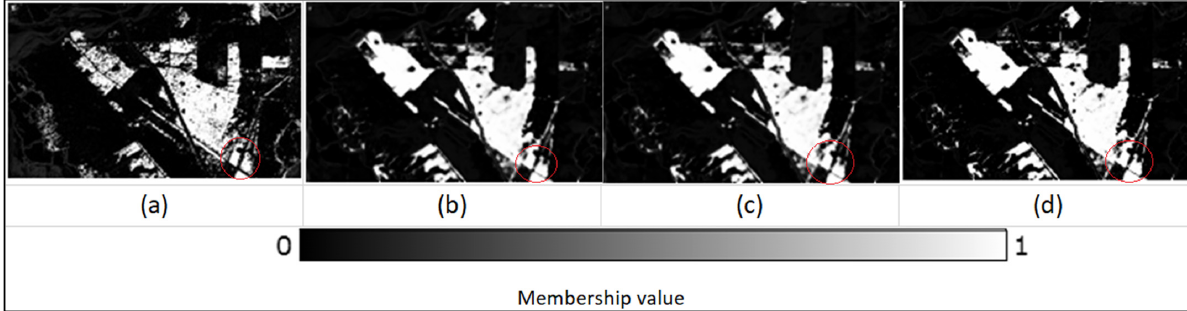
Figure 12. Example of fuzzy local spatial information classifiers in image detail preservation: ( a ) Reference fraction image for ‘Eucalyptus’ class, ( b ) FCM-S classifier output fraction image with vague edges, ( c ) FLICM classifier output fraction image with vague edges, and ( d ) ADFLICM classifier output fraction image with edges better preserved.